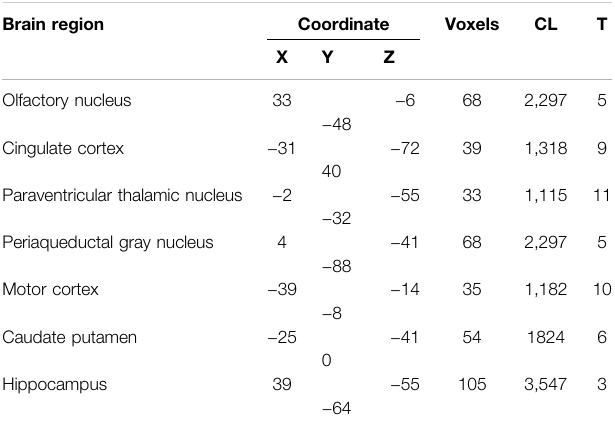
TABLE 1 | Differences between FC